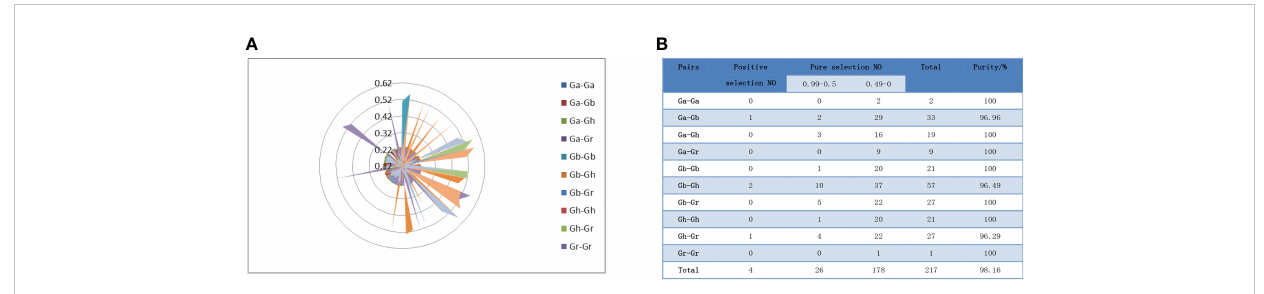
FIGURE 5 Analysis of the non-synonymous (Ka) to synonymous (Ks) ratio. (A) Nonsynonymous (Ka) and synonymous (Ks) divergence values for Ga – Ga, Ga-Gb, Ga-Gr, Ga-Gh, Gb-Gb, Gb-Gr, Gb-Gh, Gr-Gr, Gr-Gh, and Gh-Gh are shown in the circular chart. (B) Prediction number of the duplicate gene pairs involved in different combinations of four cotton species.